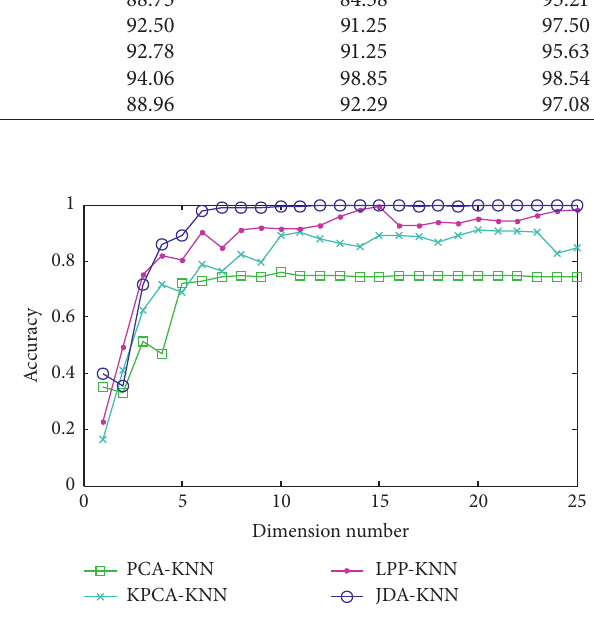
Figure 12: Diagnosis results of Case 1 by using PCA, KPCA, LPP, and JDA under different dimension numbers.